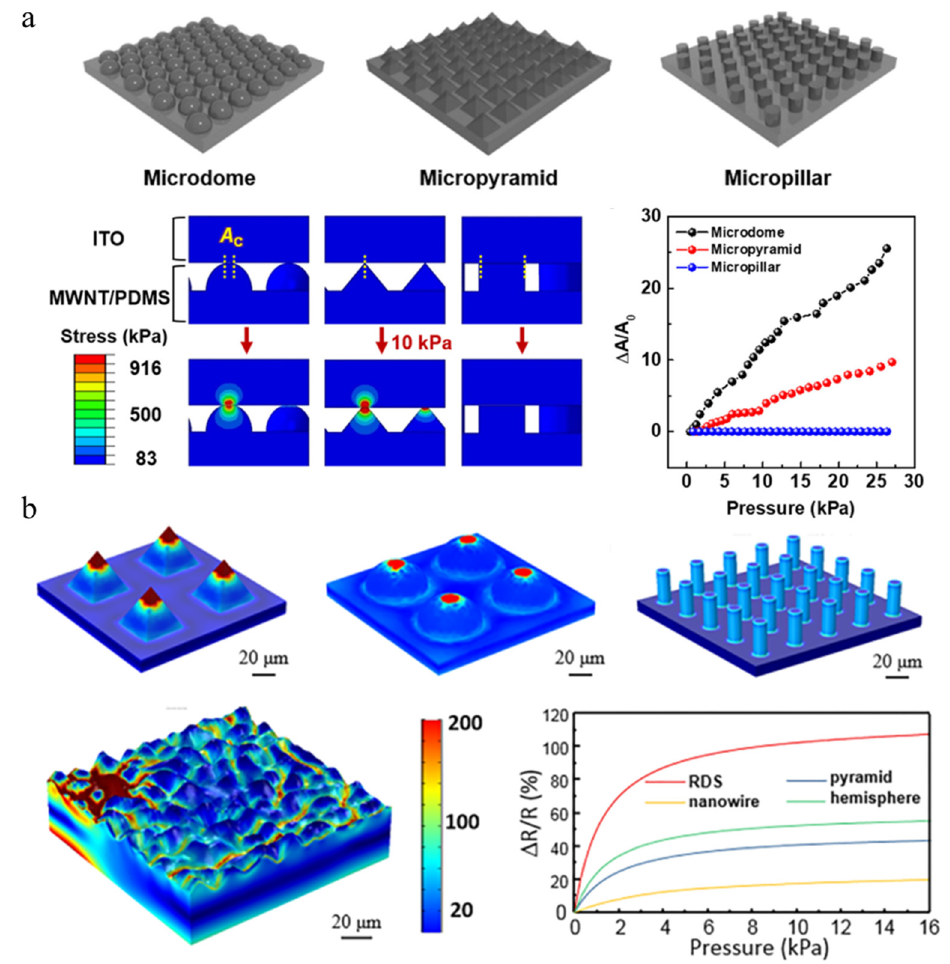
Figure 6. Comparison of the performance and mechanisms of pressure sensors with different microstructures. ( a ) Schematic illustration of differently microstructured arrays of pressure sensors. Calculation of localized stress distributions in response to pressure and relative contact-area changes in response to pressure determined by finite-element analysis (FEA) [144]. ( b ) The simulation results of pressure distribution and resistance variation versus applied pressure for different geometries under loading pressure [145].